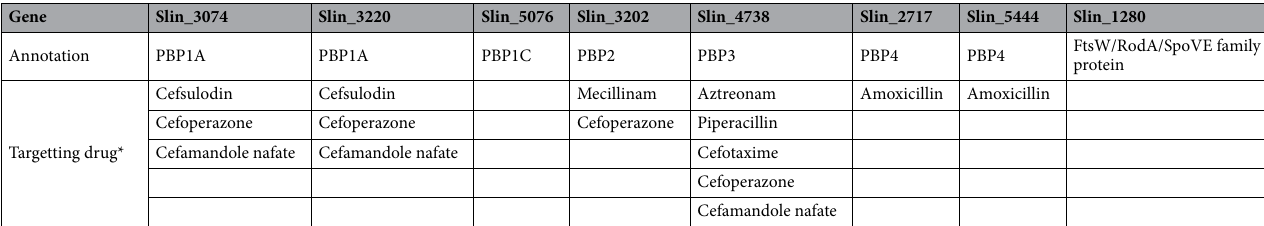
Table 3. Genes encoding PBPs in S. linguale and putative β-lactam antibiotics potentially targeting the PBPs. Genes encoding PBPs in S. linguale ATCC33905 strain are listed based on BLAST search. *Putative β-lactam antibiotics potentially targeting the PBPs of S. linguale are listed based on the results of affinityassays for E. coli PBPs by previous studies 28,37–41